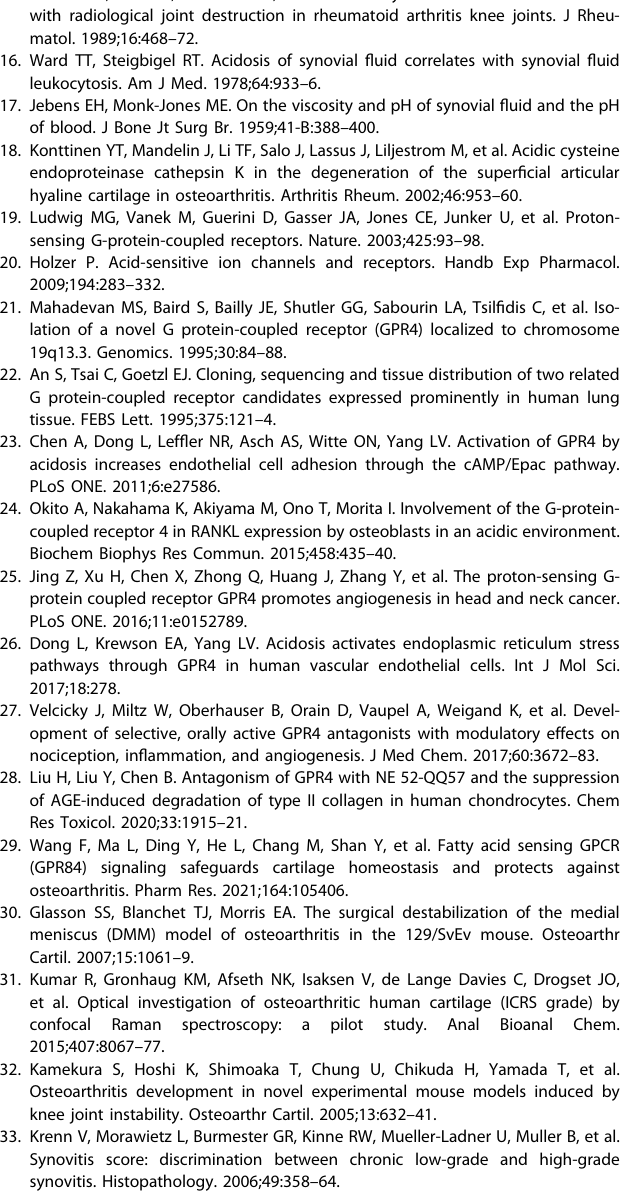
Fig. 7 GPR4 regulates cartilage matrix homeostasis through the CXCR7/CXCL12 signaling pathway. A The mRNA expression of Cxcl12 in primary chondrocytes from WT or littermate Gpr4 KO mice. n = 3. Data are presented as mean ± s.d. ** p < 0.01, using unpaired two-tailed Student ’ s t test. B The mRNA expression of Cxcr7 in primary chondrocytes from WT or littermate Gpr4 KO mice was evaluated. n = 3. Data are presented as mean ± s.d. *** p < 0.001, using unpaired two-tailed Student ’ s t test. C Representative images of IHC staining of CXCR7 in articular cartilage sections from Sham- or DMM-operated mice with Lenti-Gpr4 or Lenti-Ctrl infection (refer to Fig. 2B). Scale bars, 50 μ m. D Cxcr7 knockdown reduced GPR4 overexpression-induced cartilage catabolic gene Mmp13 , Nos2 , and Il-6 upregulation. Vector control (Vec) or Gpr4 overexpressing ATDC5 cells were transfected with the control small interfering RNA (siCtrl) or si Cxcr7 and exposed to IL-1 β (1 ng/ml) for 24 h. Expression of mRNA was analyzed by qRT-PCR. n = 3. Data are presented as mean ± s.d. ** p < 0.01, *** p < 0.001, ns, no signi fi cant difference using two-way ANOVA followed by Tukey ’ s post hoc test. E ATDC5 cells were transfected with vector control or Gpr4, and incubated with NE52-QQ57 (NE, 10 μ M) for 24 h. Then the cells were stimulated with IL-1 β (10 ng/ml) for indicated times. Whole-cell lysates were subjected to Western blot analysis to determine the total protein and phosphorylation levels of MAPKs, NF- κ B (p65), and I κ B α . F Chondrocytes from GPR4 KO mice and WT mice were stimulated with or without IL-1 β (10 ng/ml) for 5 min. The protein and phosphorylation levels of MAPKs, NF- κ B (p65), and I κ B α were evaluated by Western blot. G Representative immunostaining images of p65 nuclear localization (left) and quanti fi cation of the percentage of cells with nuclear p65 (right). GPR4 overexpressing ATDC5 cells were treated with NE52-QQ57 (NE, 10 μ M) or IL-1 β (1 ng/ ml) for 12 h, and then subjected to immuno fl uorescence staining. Data are presented as mean ± s.d. *** p < 0.001, one-way ANOVA followed by Bonferroni ’ s test was used for statistical analysis. H NF- κ B reporter gene activity in GPR4 overexpressing ATDC5 cells treated with NE52-QQ57 (NE, 10 μ M) or IL-1 β (1 ng/ml) for 12 h. Data are presented as mean ± s.d. *** p < 0.001, one-way ANOVA followed by Bonferroni ’ s test was used for statistical